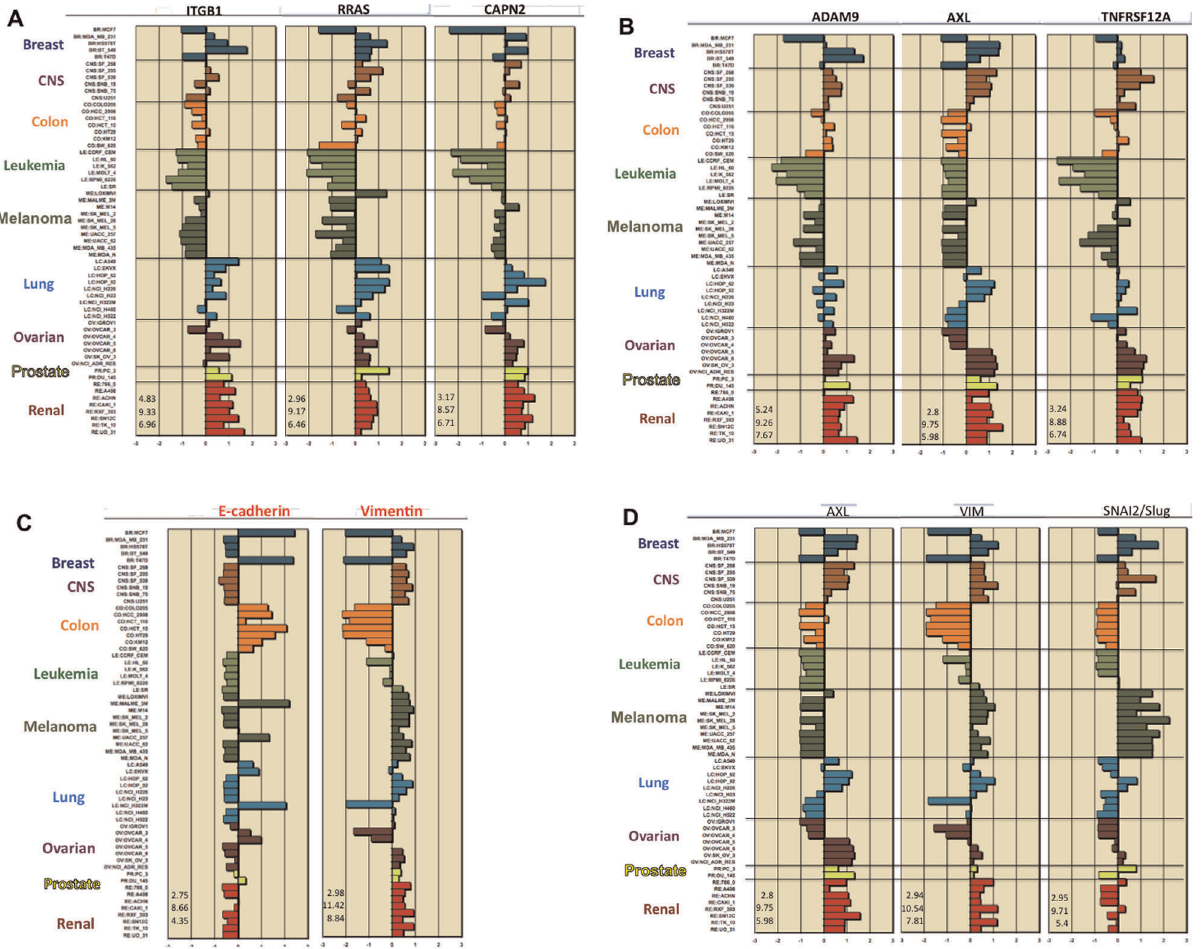
Figure 6. Relative gene expressions for the NCI-60 human tumor cell lines. Bars to the right show increased expression, bars to the left show decreased expression relative to the expression mean. Each panel shows the lowest, highest and mean expression levels (numbers at the lower left from top to bottom). Expression values are normalized as z-scores (see Methods). The horizontal axes are marked in standard deviations from the mean. (A) Expression profiles for RRAS, ITGB1, and CAPN2. (B) Expression profiles for ADAM9, AXL, and TNFRSF12A. (C) Epithelial and mesenchymal gene expression profiles, indicated by CDH1 (E-cadherin) and VIM (vimentin) respectively, showing their inverse relationships. (D) Comparison of expression profile of migration-related genes, represented by AXL, with that of mesenchymal-related genes, represented by VIM and SNAI2 (Slug).